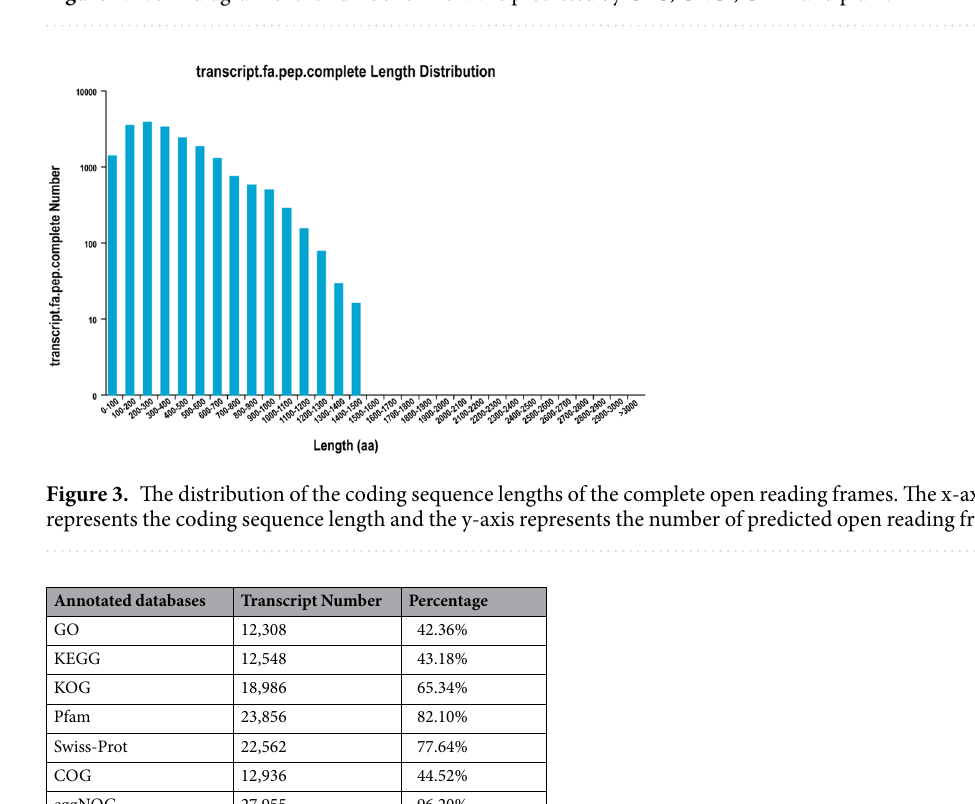
Figure 2. Venn diagram of the number of lncRNAs predicted by CPC, CNCI, CPAT and pfam.